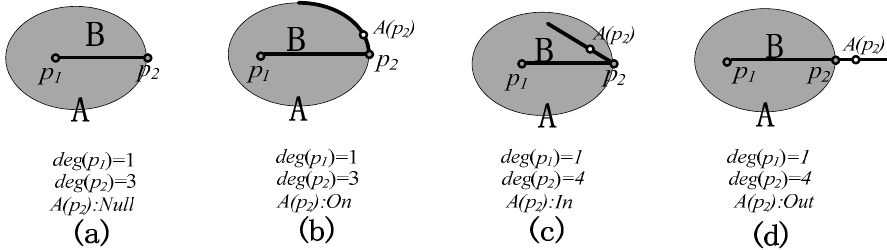
Figure 8. Examples of the intersection-lines that cannot be distinguished by only node degree but can be distinguished by the combination of node degree and adjacent point kinds. ( a ) Case of degree-pair (1,3) and the adjacent point kind of p 2 is Null; ( b ) Case of degree-pair (1,3) and the adjacent point kind of p 2 is On; ( c ) Case of degree-pair (1,4) and the adjacent point kind of p 2 is In; ( d ) Case of degree-pair (1,4) and the adjacent point kind of p 2 is Out.